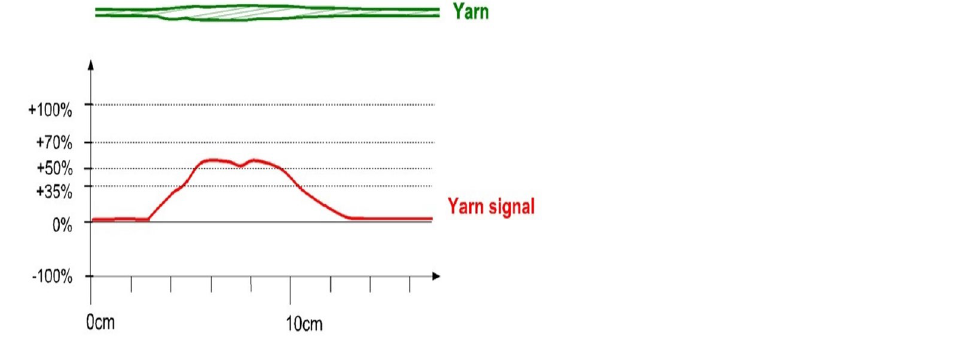
Figure 13. A thick place in a yarn and the corresponding yarn